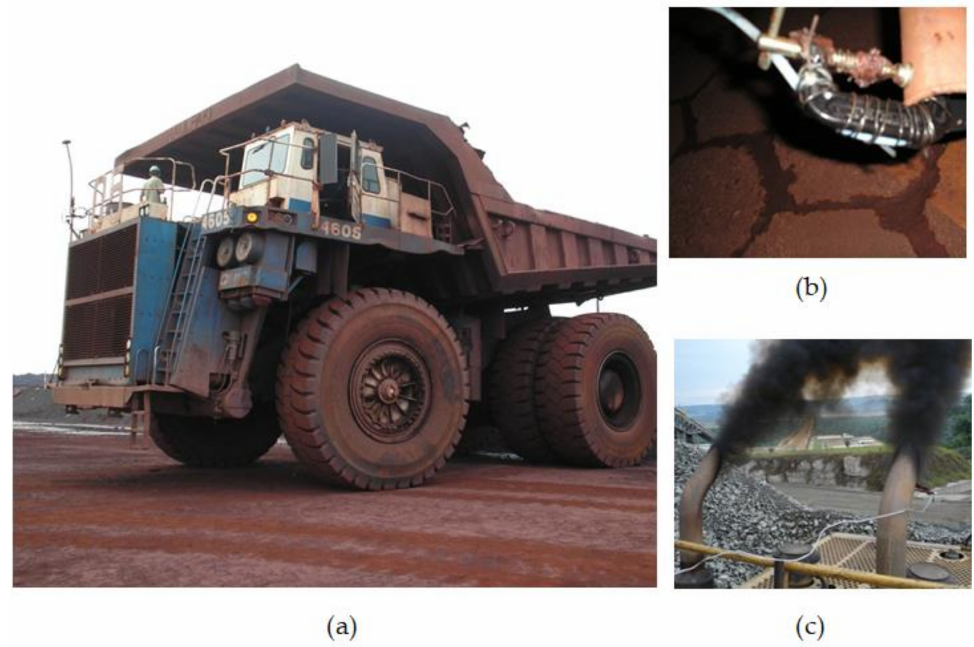
Figure 1. Photographs of: ( a ) an off-road truck for transporting iron ore, ( b ) the gas sampling nozzle, ( c ) a set of two exhaust pipes. Source: the